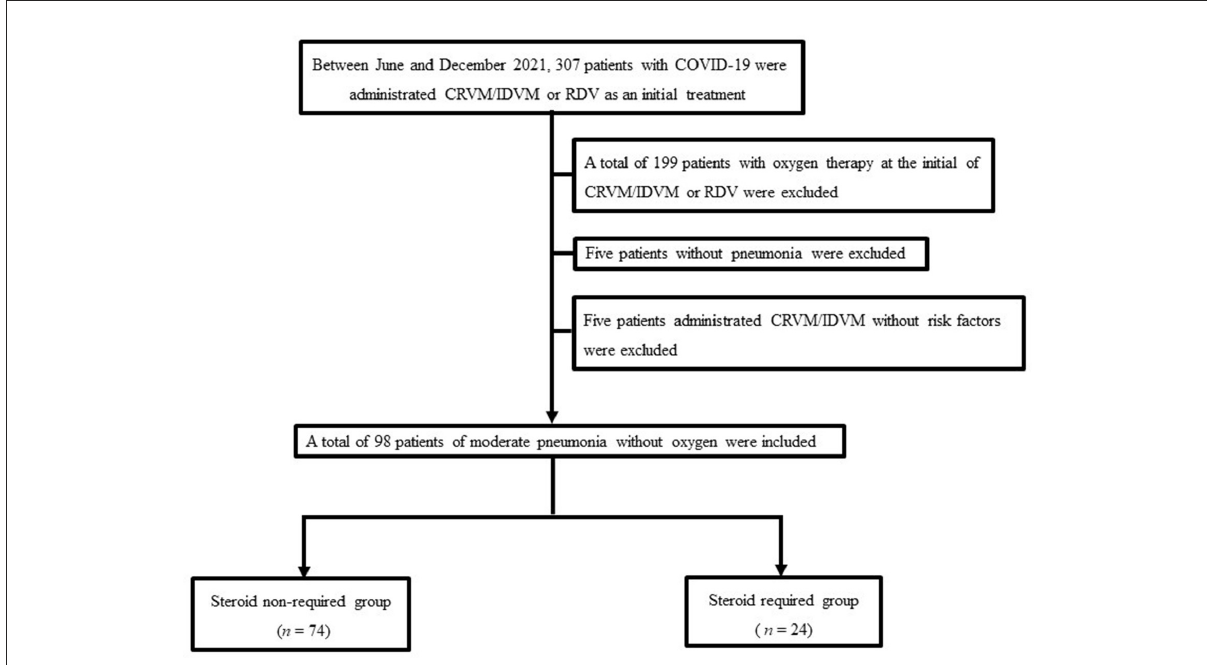
FIGURE1 The study population flowchart. The final study cohort comprised 98 patients. COVID-19, coronavirus disease 2019. CRVM/IDVM, casirivimab/imdevimab; RDV,